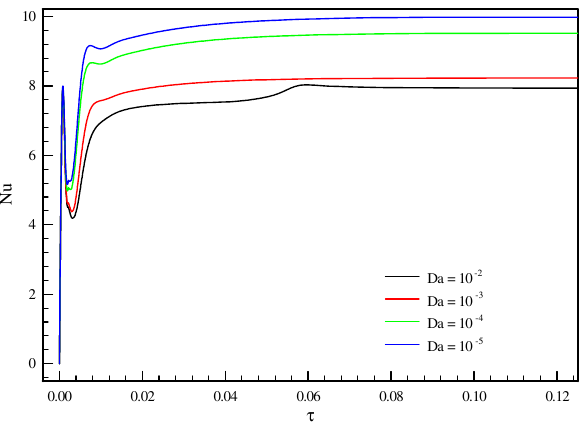
Figure 6. Nusselt number variation over the time for = 0.01, Ri = 1, and ɛ = ϕ velocity profiles are also partially affected by the porous region. In the porous zone velocity almost have an equal magnitude in particular for Da = 10 –4 and 10 –5 . As Darcy number decreases, velocity profiles in the porous zone are affected by driven flow from cylinders with harmonic motion and it is more distinguishable for mixed and forced convection where the flow is overwhelmed by shear forces. Due to the extreme fluctuations of the fluid flow, which are caused by momentary stop and change the direction of rotation of the cylinders, changes in the velocity profile in the porous region are unpredictable. Due to the lower resistance in the region with a higher Darcy number, the velocity profile has the highest value for this range of Darcy numbers (Da = 10 –2 and 10 –3 ). Figure 8a–d show the effect of various Darcy numbers and volume fraction of nanoparticles on entropy genera- tion. It is worth mentioning here that entropy generation due to viscosity and heat transfer is dispensed in dimensionless form. According to the second law of thermodynamics, all or part of the exergy that is proportional to the production of entropy disappears. Entropy is studied to determine the reversibility or irreversibility of a process in a system. For all figures, the increase of the Richardson number reduces entropy generation owing to the reduction in shear rate and the predominance of free convection. Moreover, increasing the nanoparticles improves the viscosity of the fluid and as a result, increases the entropy generation; however, as the Richardson number magnifies and the resulting inertial forces decrease, the effects of increasing the nanoparticle volume fraction in this comparison become negligible. One can notice from the figure that entropy generation number due to viscosity effects are much less than entropy generation caused by heat transfer; therefore, its effect is negligible due to small velocity gradients in presence of porous zone. By comparing the figures, it can be seen that with decreasing pore diameter, which leads to decreasing permeability, the number of entropy generation due to both heat transfer and viscosity effects increases. The total entropy generated increases maximum by 26% and minimum 18.5% for decreasing the Darcy number and also by increasing the volume fraction of solid par- ticles from 0.01 to 0.03, the number of total entropy generation for Ri = 0.1 increases by about 19%. Figure 9a and b illustrate changes in performance evaluation criteria (PEC) for different volume fractions of nanoparticles and Darcy numbers. The PEC parameter compares the Nusselt number and the coefficient of friction at the heated wall. This parameter is a measure of the heat transfer enhancement to pressure drop increment applied to the system. When the increase in heat transfer overcomes the pressure drop augmentation, this number grows to more than one, which indicates the system is cost-effective. As can be seen in the graphs, bolstering buoyancy forces leads to escalating the PEC parameter. As Darcy number increases from 10 –5 to 10 –2 , the PEC parameter for Ri = 0.1, 1, and 10 increase 12.43%, 18.95%, and 23.43%, respectively. Moreover, adding nanoparticle to base fluid from 0.01 to 0.03 leads to dropping PEC value of 17.43%, 12.01%, and 10.63% for Ri = 0.1, 1, and 10, in turn. Figures 10 and 11 present a detailed comparison of isotherms contours and streamlines contours for var- iegated Darcy number, φ = 0.01, τ = 0.1, ɛ = 0.5. It can be seen from the isotherms contours that for a fixed value of Darcy number by increasing Richardson number the temperature gradients spread around the porous zone. On the contrary, by reducingthe effect of buoyancy forces, the thermal layers are concentrated at the bottom of the enclosure. Moreover, for higher Darcy number and lower Richardson number minor temperature gradients occurs in the porous zone. However, this is verifiable for Da = 10 –4 and Ri = 0.1. The presence of a high-temper- ature thermal layer as well as a denser thermal layer formed near the wall for Ri = 0.1 is the reason for the improvement of heat transfer in forced convection. As the Darcy number decreases, the thermal boundary layers become thinner. Moreover, as the permeability decreases (ergo less fluid penetration in the porous zone) more cold thermal plumes sway to the right of the chamber which helps to enhance the cooling process. As can be seen from streamline contours, the movement of the lid generates a clockwise rotational flow which is also affected by the harmonic movement of the cylinders and the permeability of the porous medium. Owing to the